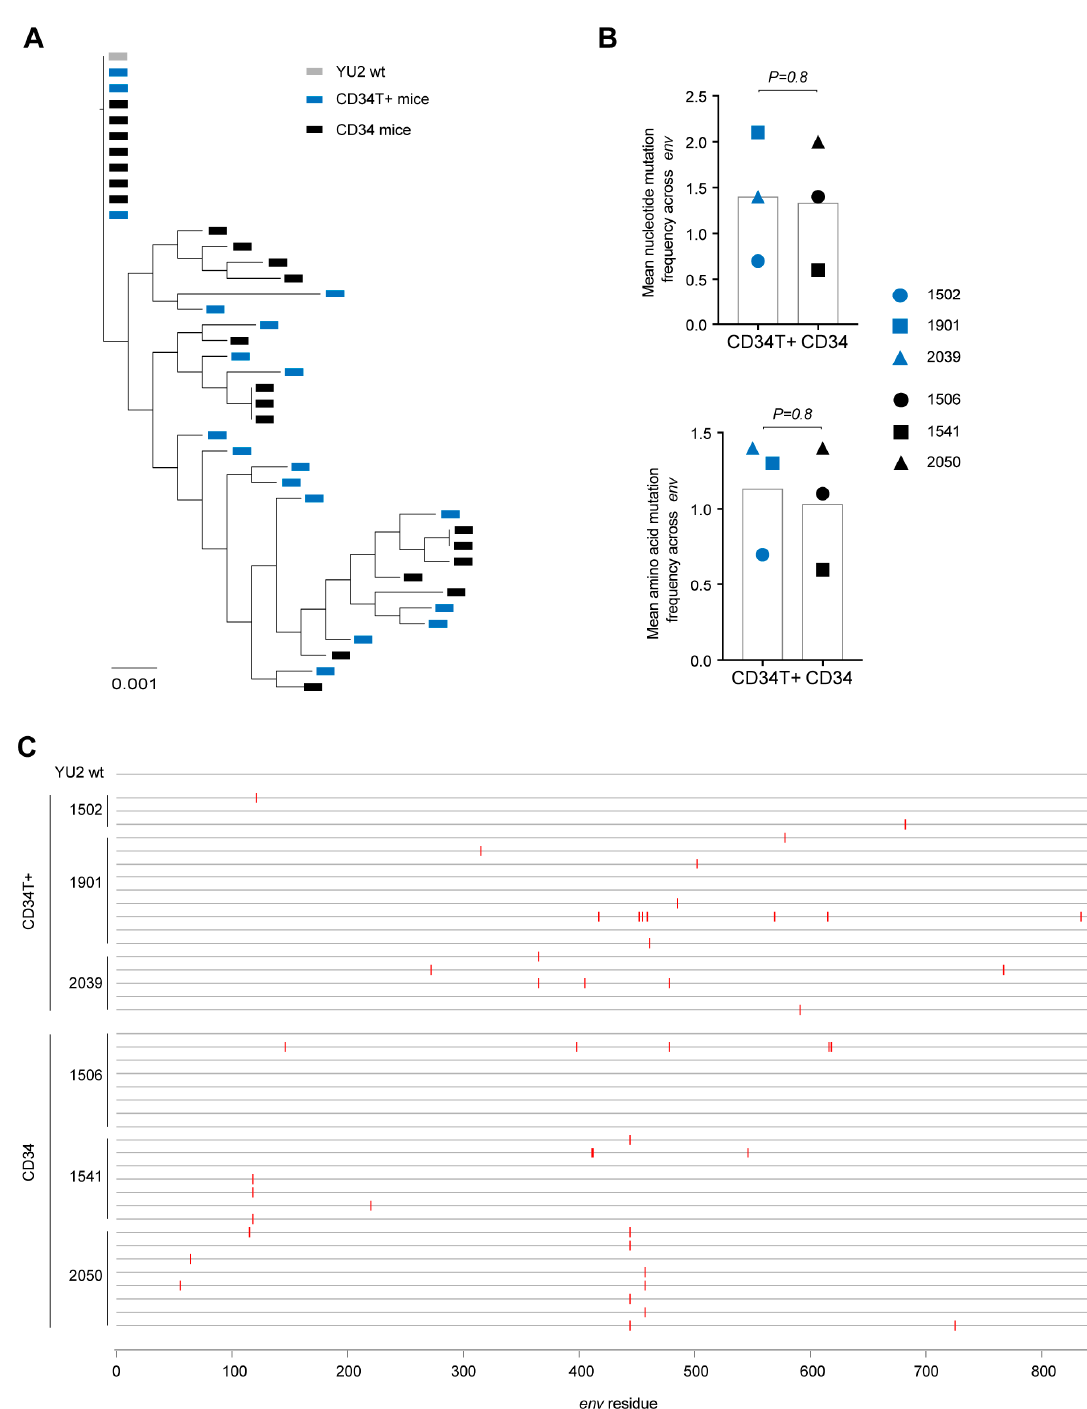
Figure 3. In vivo diversification and evolution of HIV-1 infected mice. ( A ) Phylogenetic tree of SGS-derived env sequences from the plasma of CD34T+ mice and CD34 mice at day 21 post post i.r. or i.p. challenge with NL4-3 YU2 HIV-1 respectively. ( B ) Analysis of mutation rates at the amino acid and nucleotide level in the env gene of mice from ( A ). ( C ) Amino acid alignment of plasma SGS-derived env sequences from mice analyzed in ( A , B ). Red bars indicate amino acid residues with mutations relative to the wild-type NL4-3 YU2 HIV-1 env . Amino acid numbering is based on HIV-1 YU2 env . i.r. intra-rectal, i.p. intra-peritoneal.